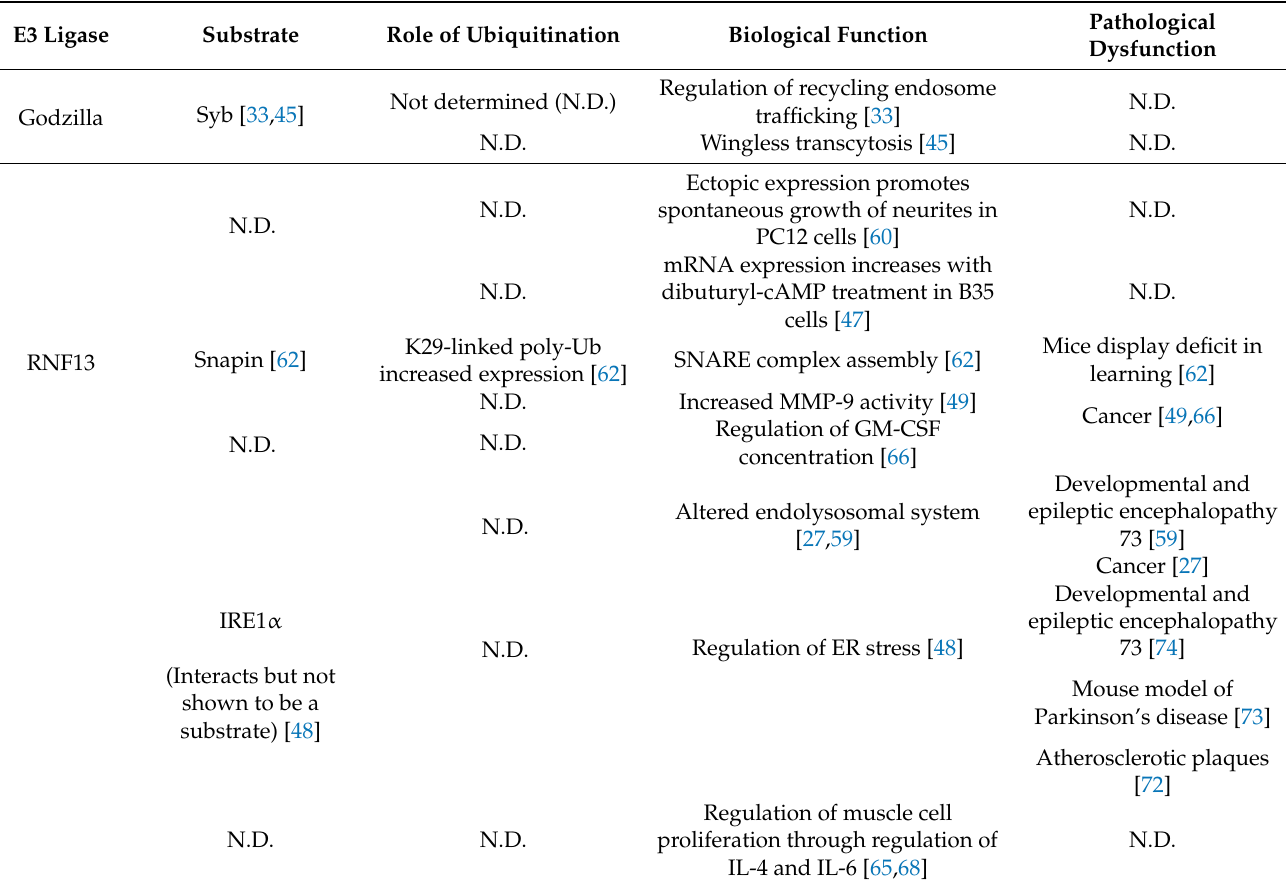
Table 1. Summary of the substrates, the role of their ubiquitination, and their known biological functions and pathological dysfunctions for each E3 ligase discussed in the current